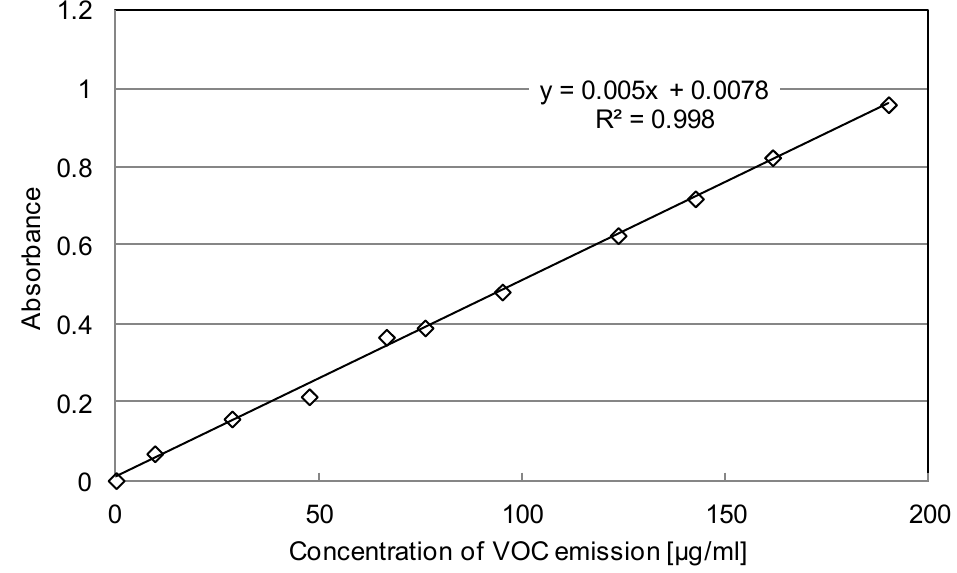
Figure 7. Mathematical solvers for the calibration